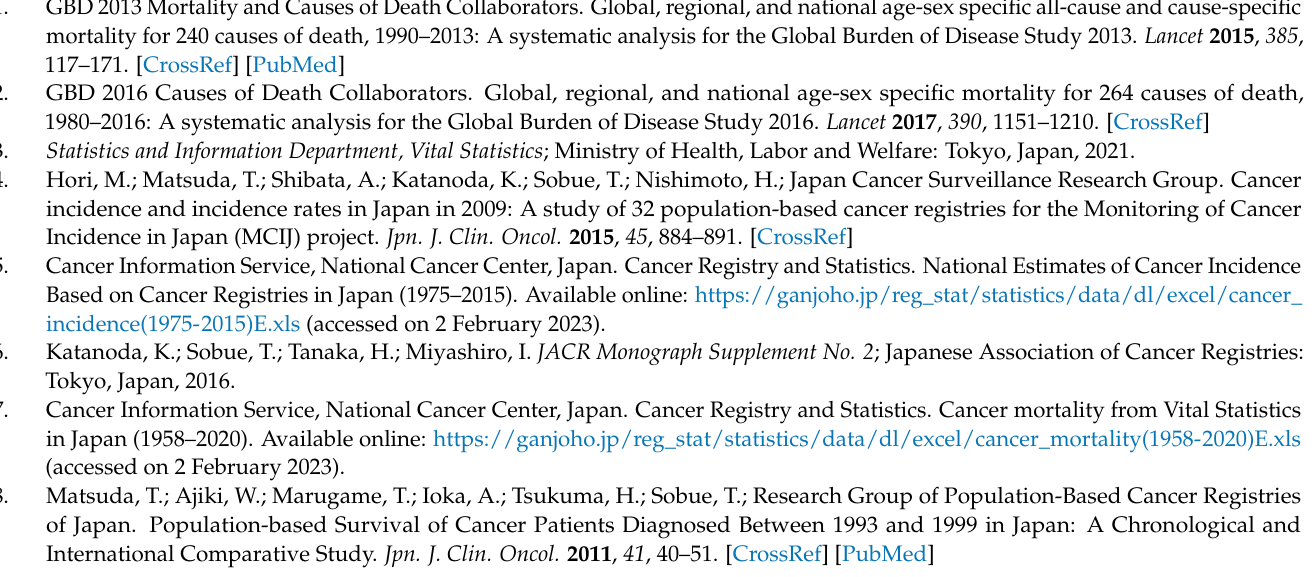
Figure A2. Relationships between cancer sites and cause of death (female patients). The diagram above illustrates the correlation between the site of cancer incidence and the specific cause of death. The left side of the diagram represents the site of cancer incidence, while the right side represents the classification of causes of death. The number before the cause of death is the code for the cause of death classification as defined by the Japanese Ministry of Health, Labour and Welfare. The height (width of the bands) represents the number of individuals, with thicker bands indicating higher numbers. It is evident that deaths due to index cancer are prevalent, but for causes other than cancer, heart disease and respiratory system diseases are more